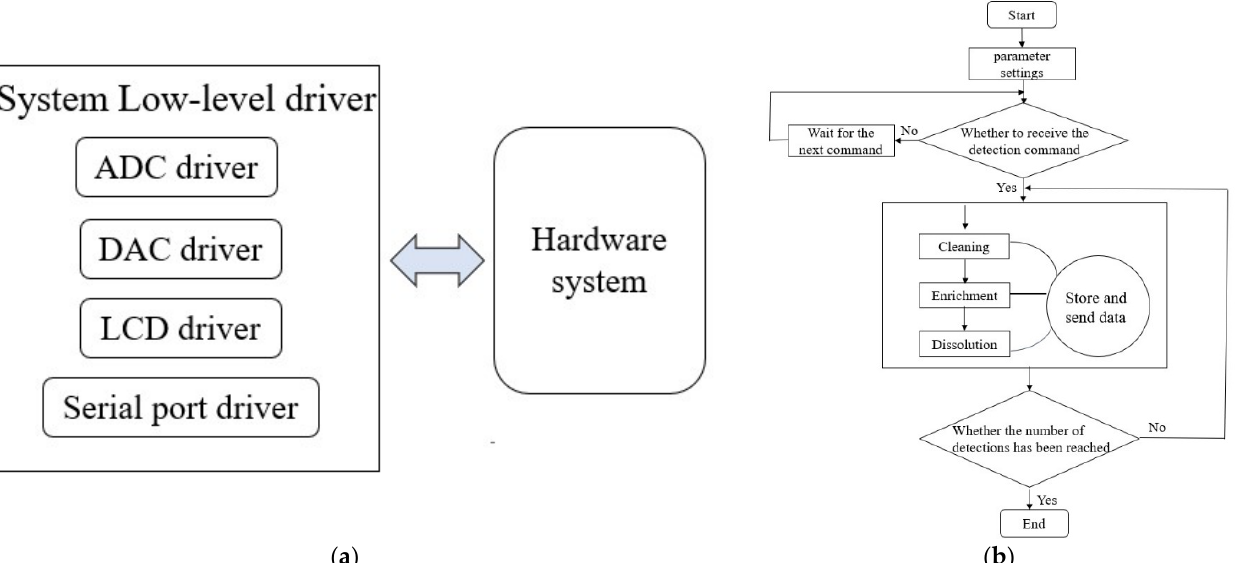
Figure 3. The program of the embedded software system: ( a ) design block diagram; ( b ) flowchart.